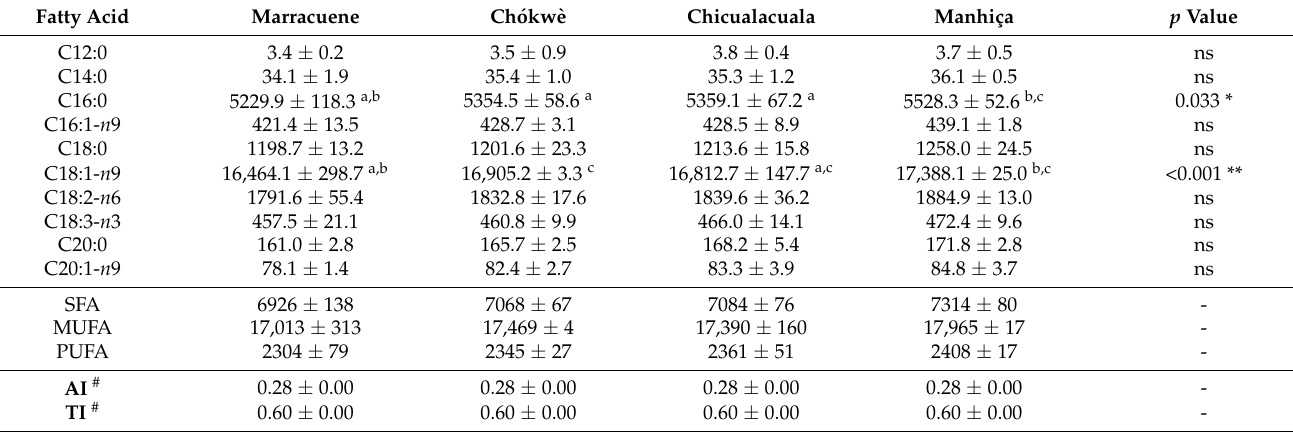
Table 2. Fatty acids composition (mg/100 g of flour) and atherogenic (AI) and thrombogenic (TI) indices of S. madagascariensis fruit flour ( nfuma ) from four districts (Marracuene, Manhiça, Ch ó kw è and Chicualacuala) in southern